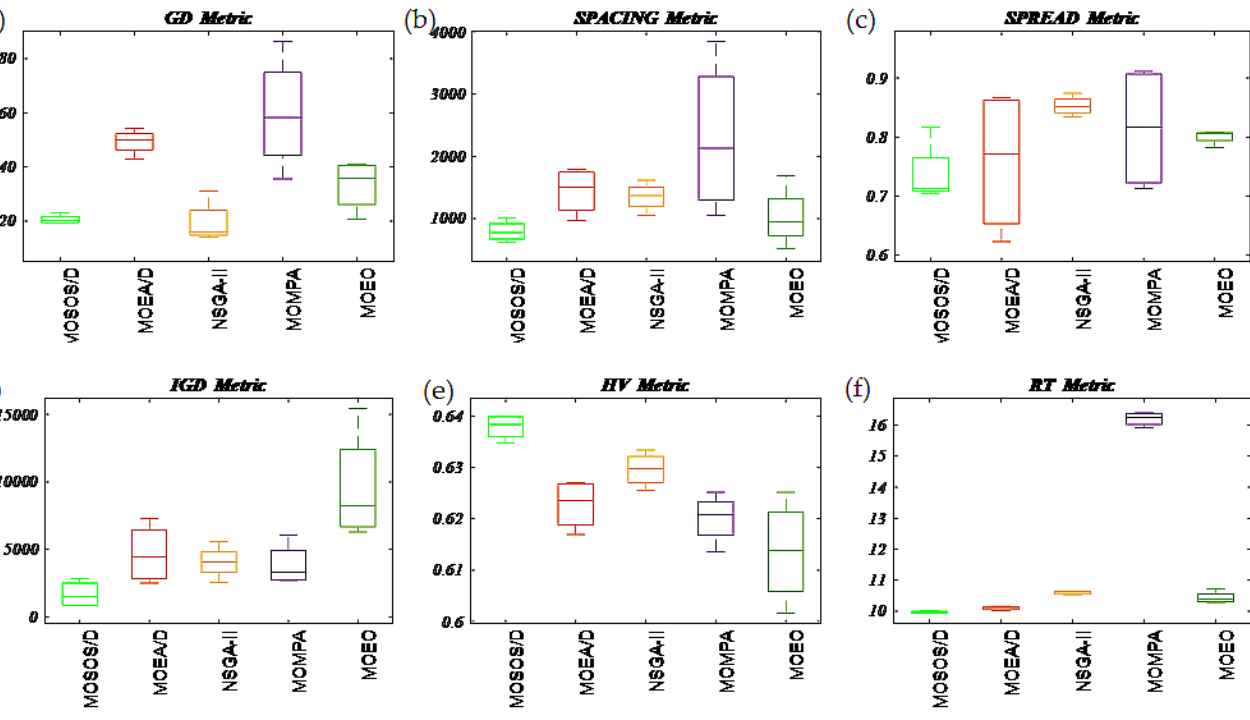
Figure 18. The boxplots of the considered algorithms for the 10-bar truss for various metrics ( a